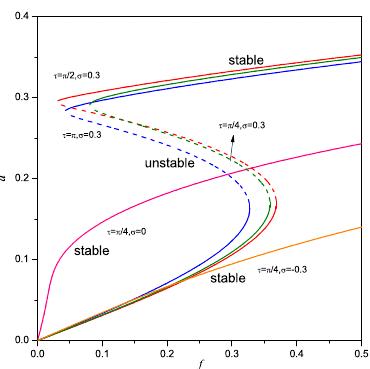
Figure 3. Amplitude of the response as a function of amplitude of the excitation for several detunings. It is seen that the saddle-node (SN) bifurcations located on the primary branch. Then, to determine the lowest excitation amplitude, the locus of the SN bifurcation points in the f − σ plane is obtained in Figure 4 for p = − 0.05 and different values of τ . It is shown that the minimum point determines the minimum excitation level below and the excitation frequency band can also be determined. As the time delay increases, the amplitude of the minimum excitation also decreases.